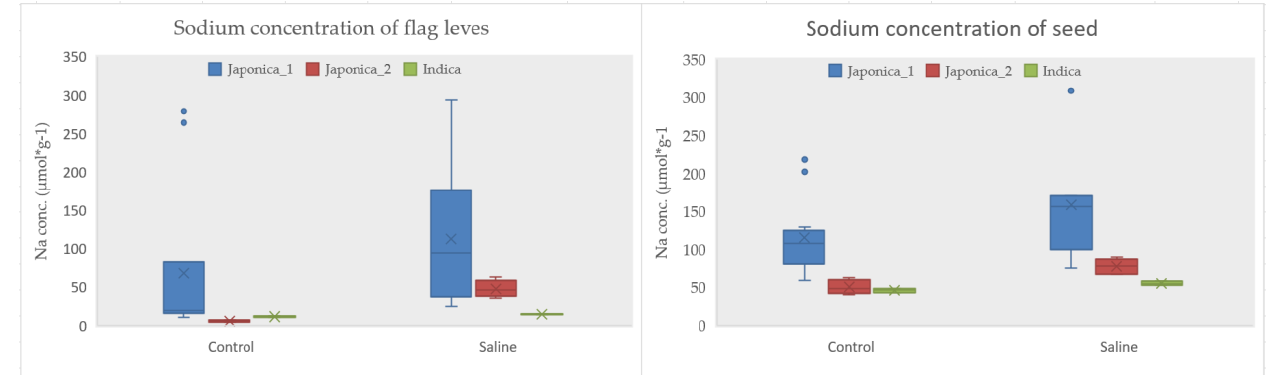
Figure 3. The sodium distribution in flag leaves and ripened seeds among the rice varietal groups. The dots are outliers which are belong to the M488 variety.